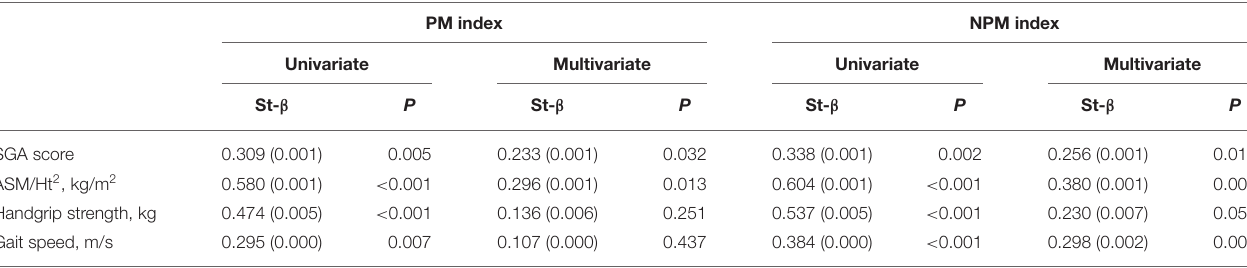
TABLE 4 | Comparison of nutritional and physical performance according to the PM